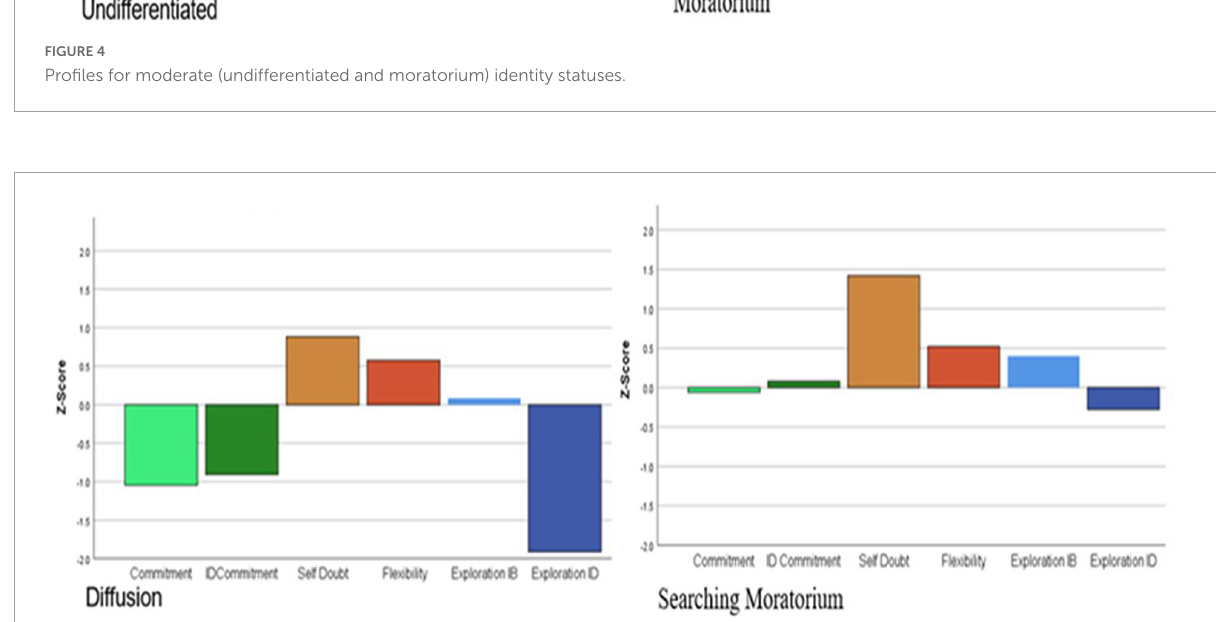
FIGURE5 Profiles for delayed (diffusion) and mixed (searching moratorium) identity statuses.